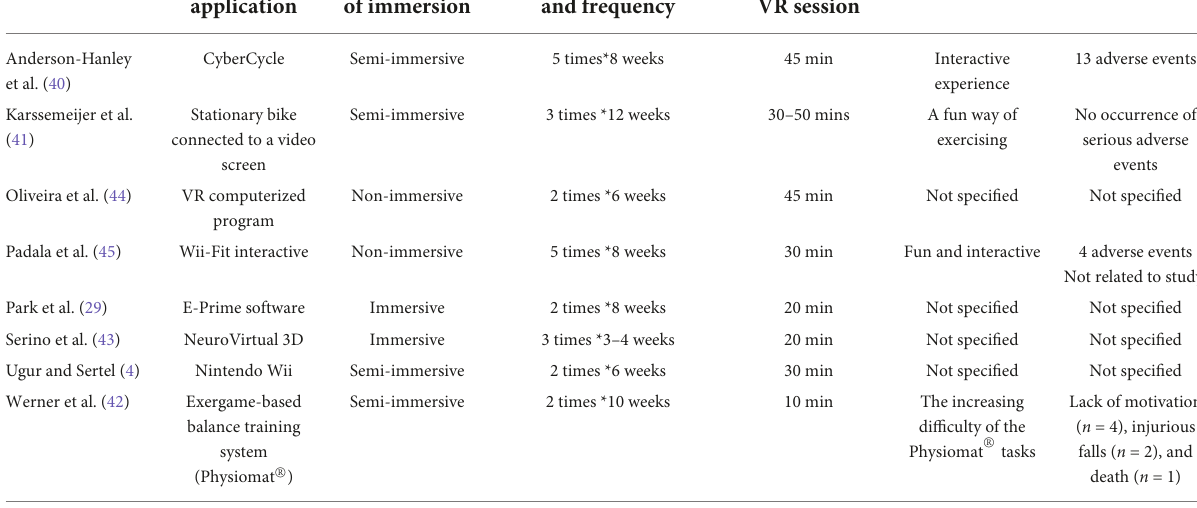
TABLE 2 Virtual reality (VR) levels of immersion, characteristics of the VR programs, and user experience.